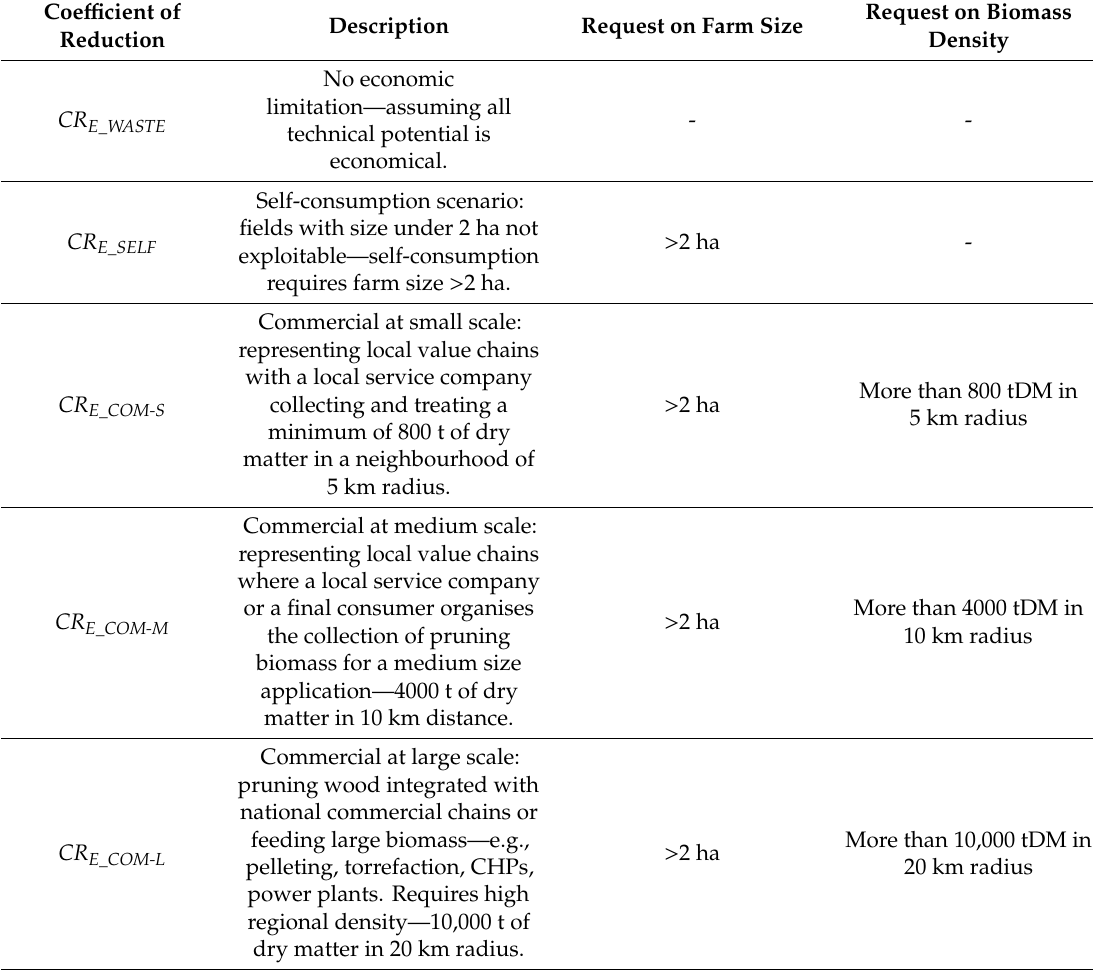
Table 3. Limitations of CRs for economic potentials